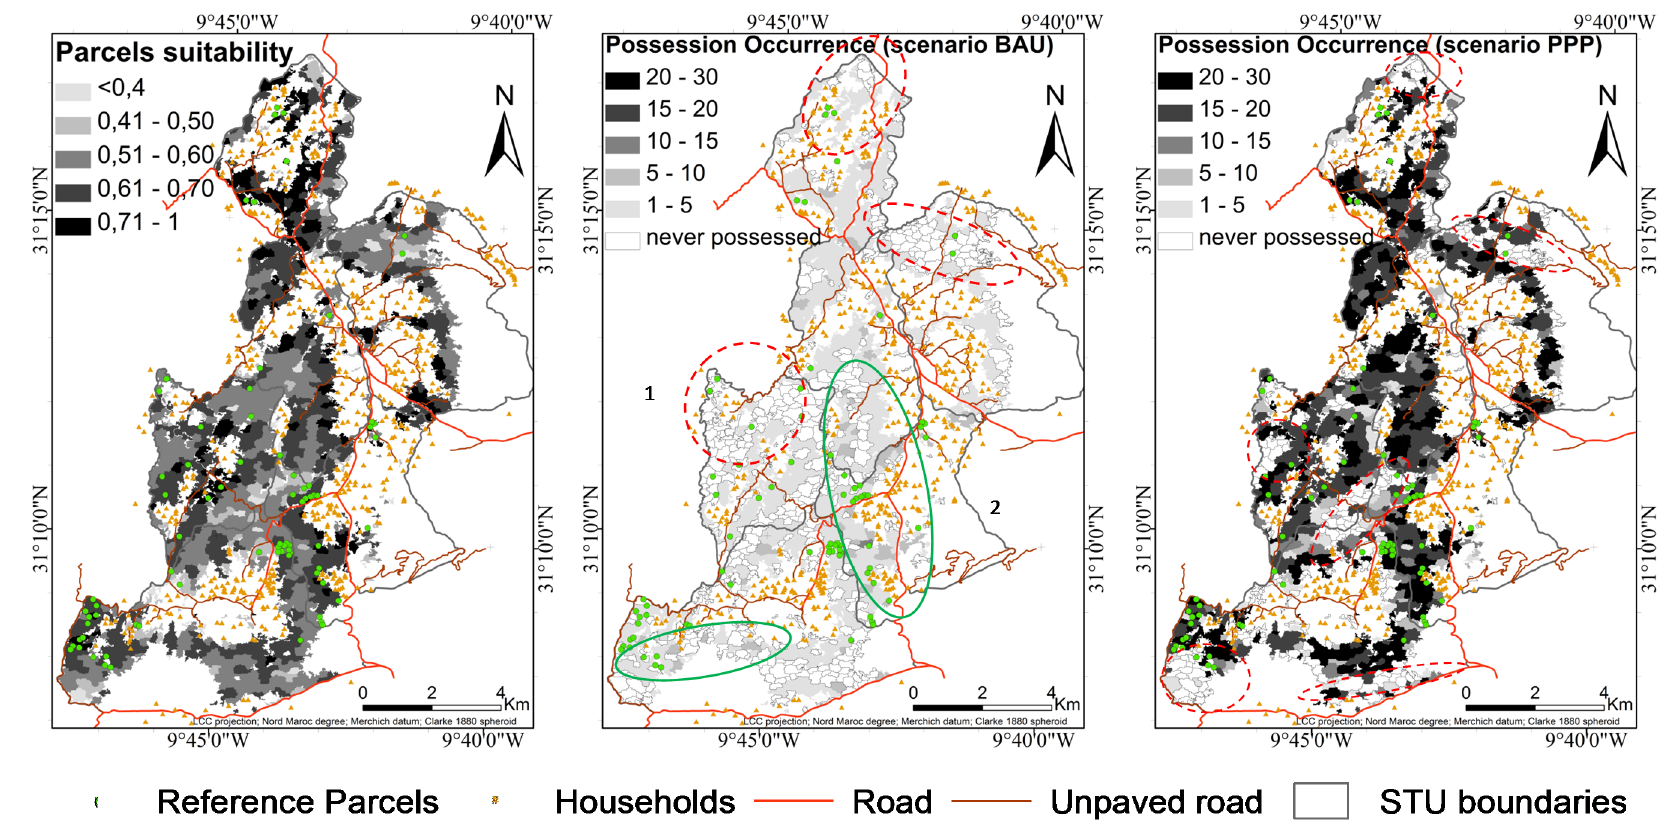
Figure 8. Spatial distribution of the parcels suitability and of the possession dynamics (BAU & PPP scenarios). Parcel suitability is quantified on a 0–1 scale according to Figure 4. Number of occurrences: number of times a parcel is acquired among 30 repetitions. Plain green circles: areas with a high demand of argan parcels; red dotted line circles: areas with a low demand of argan parcels. 1, 2 ( BAU scenario) corresponds to the Socio-Territorial Units with the lowest (0.0014) and the highest (0.005) transition probabilities,